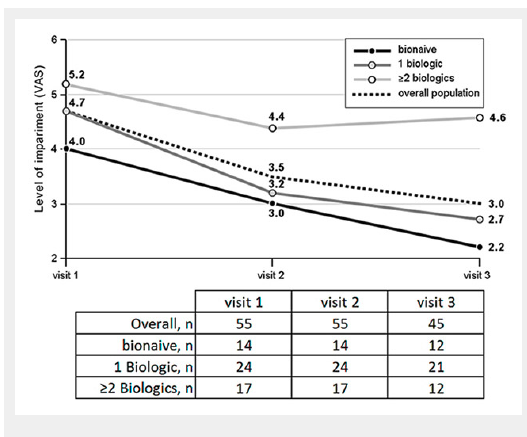
Glucocorticoid use over time: percentages of patients regularly taking glucocorticoids at the time of each visit. The numbers of patients with available information on glucocorticoid use at each visit are listed in the table.